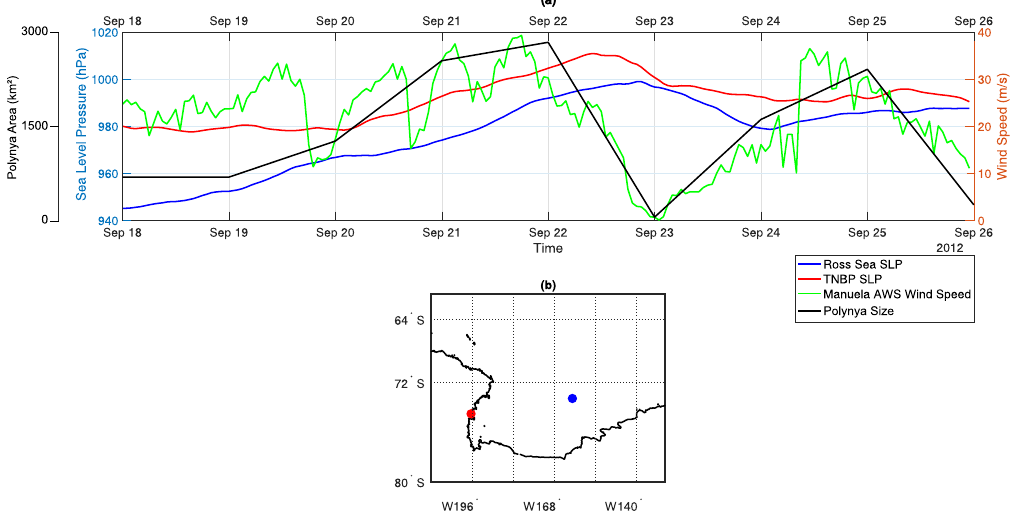
Figure 5. ( a ) Plotted together: MERRA sea level pressure from the point in the Ross Sea area and the point in Terra Nova Bay (marked in ( b )), Manuela AWS wind speed and polynya surface area. ( b ) Location of the plots from ( a